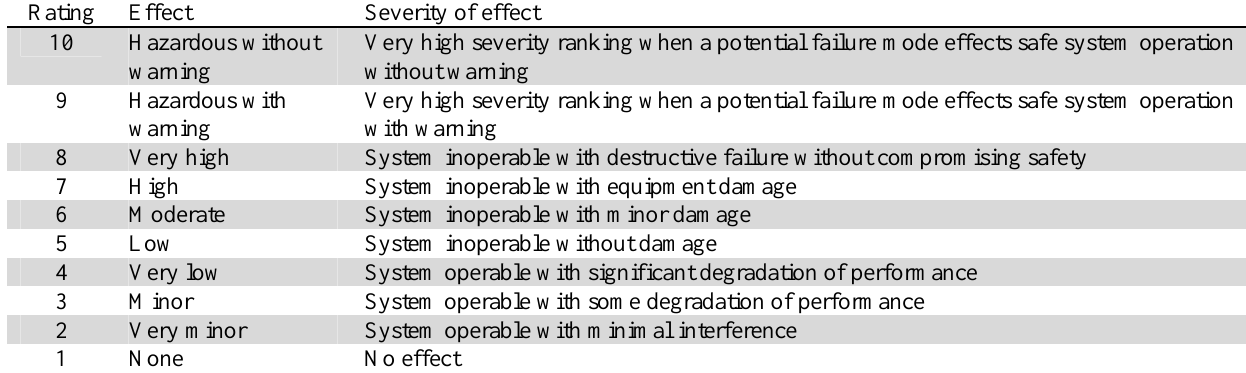
Crisp ratings for severity of a failure (Chin et al., 2008; Wang et al., 2009)